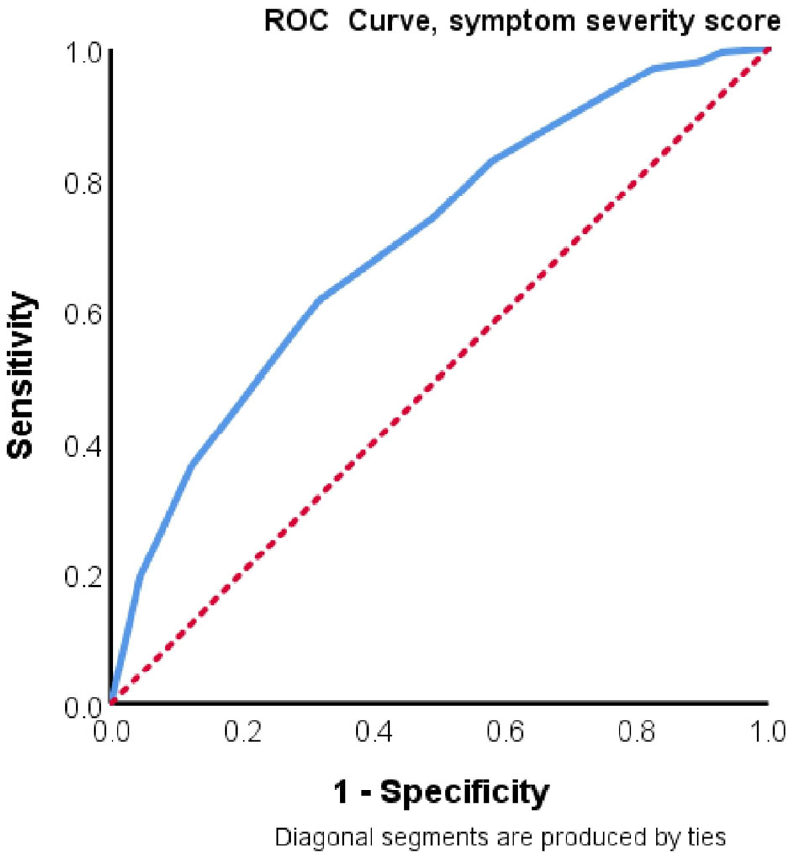
Figure 1. ROC curve of symptom severity score as a predictor of long COVID. In the univariate models, several factors in the acute illness were positively associated Figure 1 . ROC curve of symptom severity score as a predictor of long COVID. with the risk of having long COVID, such as: chest pain (RR 1.8, 95% CI 1.1–3.0, p = 0.008), dyspnea (RR 2.2, 95% CI 1.4–3.5, p = 0.001), sore throat (RR 1.6, 95% CI 1.0–2.6, p = 0.024), con- junctivitis (RR 1.9, 95% CI 1.0–3.6, p = 0.047), tachycardia (RR 10.1, 95% CI 2.3–43.3, p = 0.002), nausea (RR 2.9, 95% CI 1.2–7.0, p = 0.012), severity score ≥ 8 (RR 3.32, 95% CI 2.0–5.4, p < 0.001), hospitalization (RR 2.6, 95% CI 1.4–4.6, p = 0.001), and use of antibiotics (RR 1.6, 95% CI 1.0–2.6, p = 0.033) (Table 4). These associations remained in the multivariate model for severity score ≥ 8 (RR 2.0, 95% CI 1.1–3.5, p = 0.022), hospitalization (RR 2.1, 95% CI 1.0–4.4, p = 0.039), myalgia (RR 1.9, 95% CI 1.08–3.6, p = 0.027), tachycardia (RR 10.4, 95% CI 2.2–47.7, p = 0.003), and use of antibiotics (RR 2.0, 95% CI 1.1–3.5, p = 0.022). A high level of education was a protective factor in the multivariate model (RR 0.6, 95% CI 0.4–0.9, p = 0.029). All other factors included in the multivariate model were not significantly associated with long COVID (see Table 4). In addition, the population attributable fraction (PAF) was calculated, which was defined as the proportional reduction in the occurrence of long COVID in the study population, if exposure to a risk factor was eliminated in an alternative ideal exposure sce- nario [23]. The higher PAF for long COVID were myalgia (37%), severity score ≥ 8 (31%), and use of antibiotics (27%); hospitalization (18%) and the presence of tachycardia (14%) were less relevant at a population